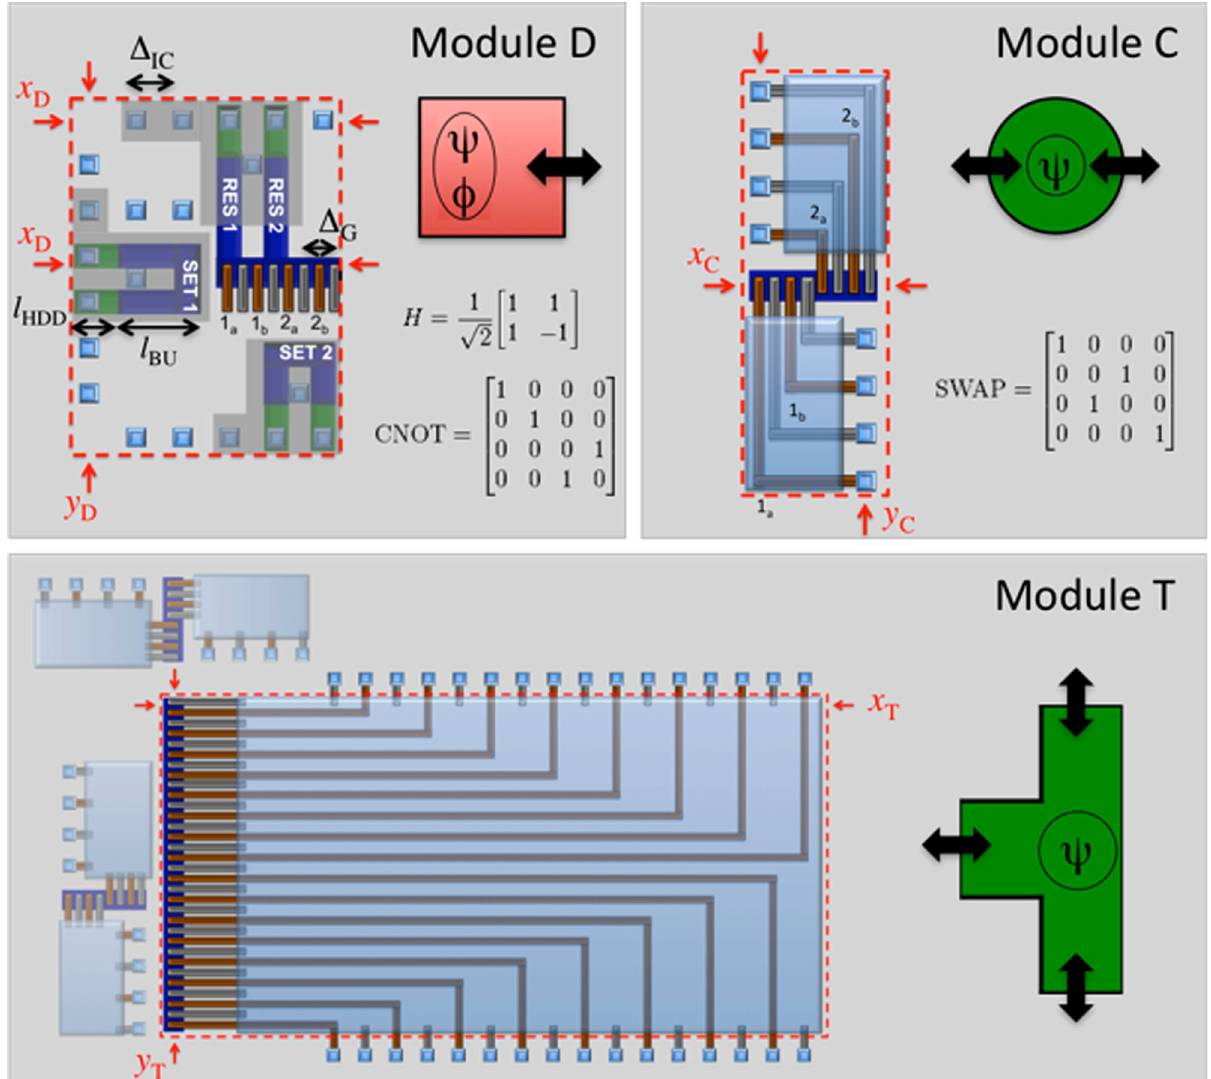
Fig. 1 The three physical building blocks constituting the virtual layer of the qubits based on exchange-only DQD qubits for the implementation of the Steane code. Schematic device mask is provided for each module together with its symbolic representation utilized in Fig. 2. Greek letters denote virtual qubits storable inside the module, whereas arrows indicate the available quantum connections to neighboring virtual qubits. Top left — Data virtual qubit ( d ) for one-qubit and two-qubit virtual gates, e.g., the Hadamard ( h ) and the CNOT. Labeled plunger gates ( orange ) control the chemical potentials of the four QDs de fi ning the two qubits. Barrier gates ( gray ) control the inter- QD tunnel coupling. Shaded areas indicate the charge sensors (SET) and the electronic reservoirs (RES) of virtual qubits 1 and 2. Black arrows denote the critical feature sizes de fi ned in the main text. Module sizes are calculated along the directions indicated by the red arrows . Top right — Chain module ( c ) for quantum communication through SWAP gates. c Bottom — T module ( t ). The module supports quantum communication along the silicon nanowire direction (in this case vertically) analogously to module ( c ). In addition, a horizontal virtual qubit chain can be connected on the left of such device to build up a T-shaped crossing with a vertical channel. Blue areas denote the space for metal interconnections between the active area over the Si nanowire and vias at the module boundary. Only plunger gates interconnections ( orange ) are depicted for clarity. Metal interconnections are disposed so that the space for surrounding ( c ) modules (depicted shaded on the left and top of t module) is taken into